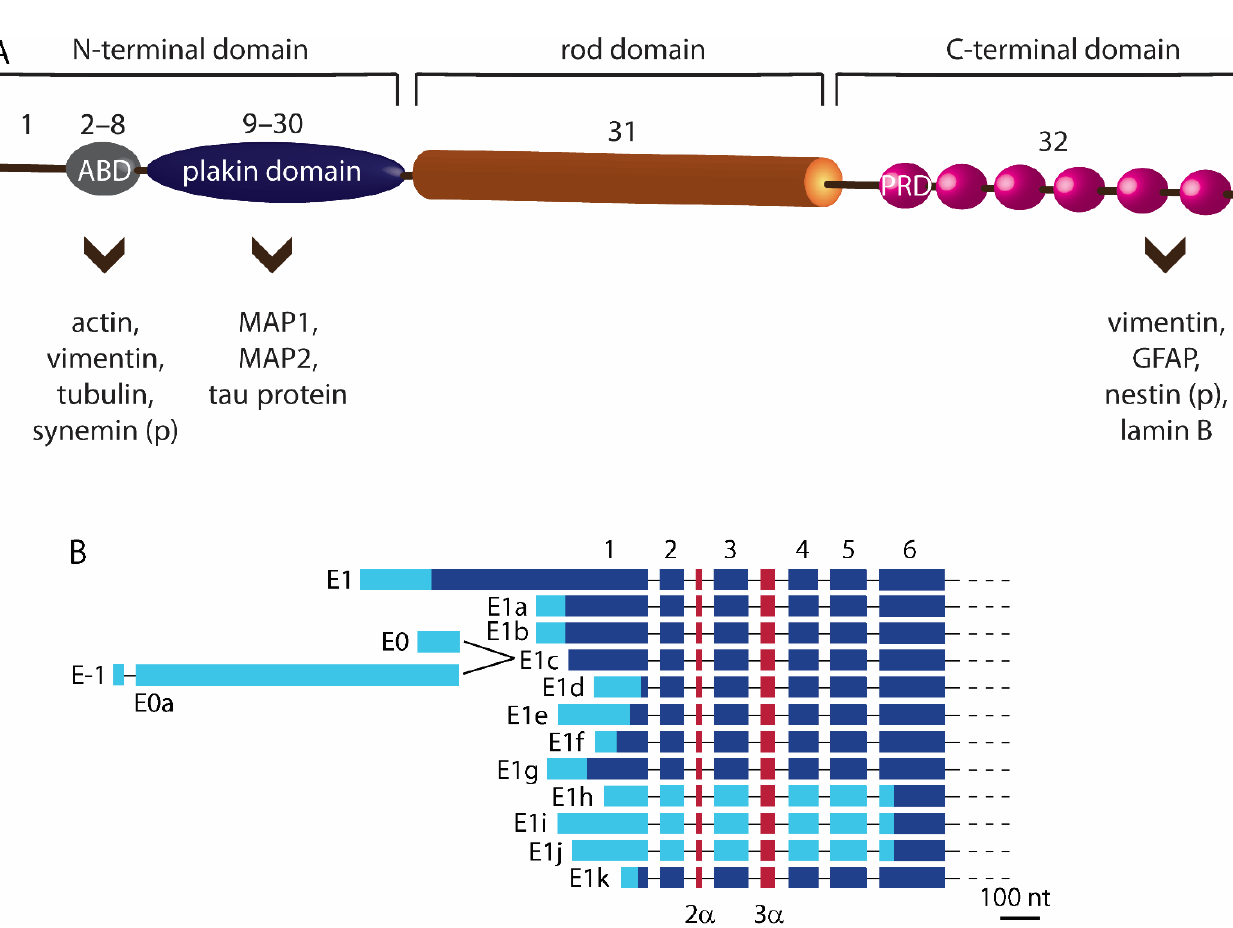
Figure 1. Schematic representation of plectin and its transcripts generated by alternative splicing of the 5’ end of the plectin gene PLEC . ( A ) The panel highlights interaction sites of cytoskeleton proteins and/or their associated proteins in astrocytes and neurons with their respective plectin domains. The C-terminal domain consists of six plectin repeat domains (PRD). ( p ), predicted interaction sites of certain IFs with plectin in astrocytes and neurons. Numbers above the schematic of plectin denote exons. ABD, actin binding domain. ( B ) Transcripts that give rise to individual plectin isoforms differ from each other only in short sequences at the 5’ end of the plectin gene. The numbers above the schematic denote consequent exons until exon 6. Exons 7 to 32 are not shown, as they are conserved among isoforms [4]. Individual exons are indicated by light and dark blue boxes, representing noncoding and coding regions, respectively. Red boxes denote two optionally spliced exons; 2 α is inserted between exons 2 and 3, while 3 α is inserted between exons 3 and 4.